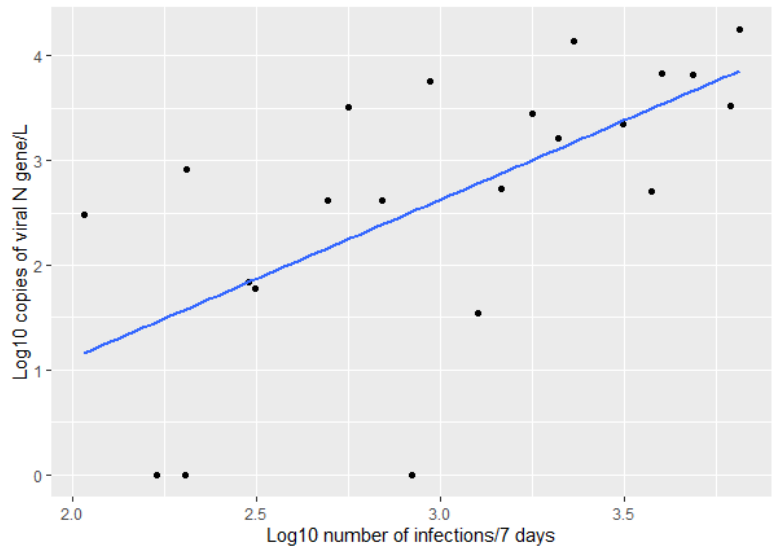
Figure 5. Correlation between the log10 transformed number of infections over the week previous to the sampling day and the log10 transformed amount of virus detected in WWTP influent (Pearson correlation = 0.632).